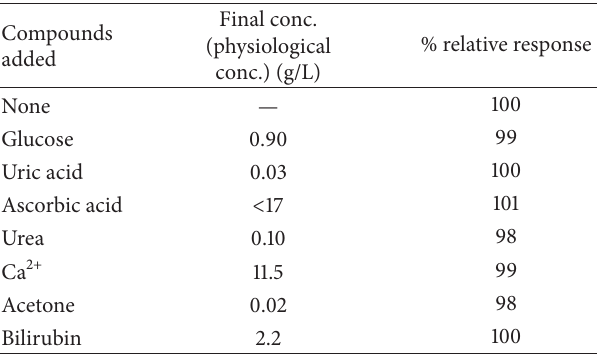
Table 4: Total cholesterol level in serum of probably healthy individuals calculated by current biosensor.